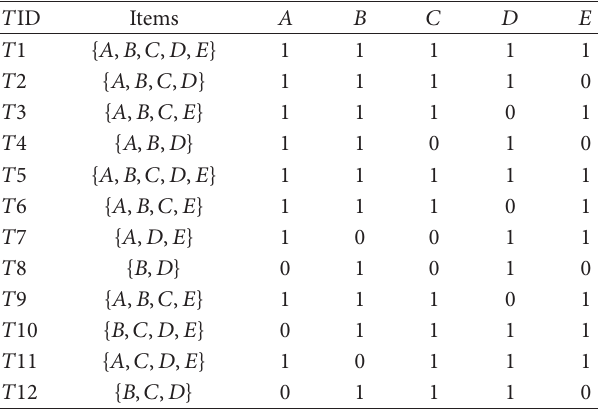
Table 1: Risk associations for height crash